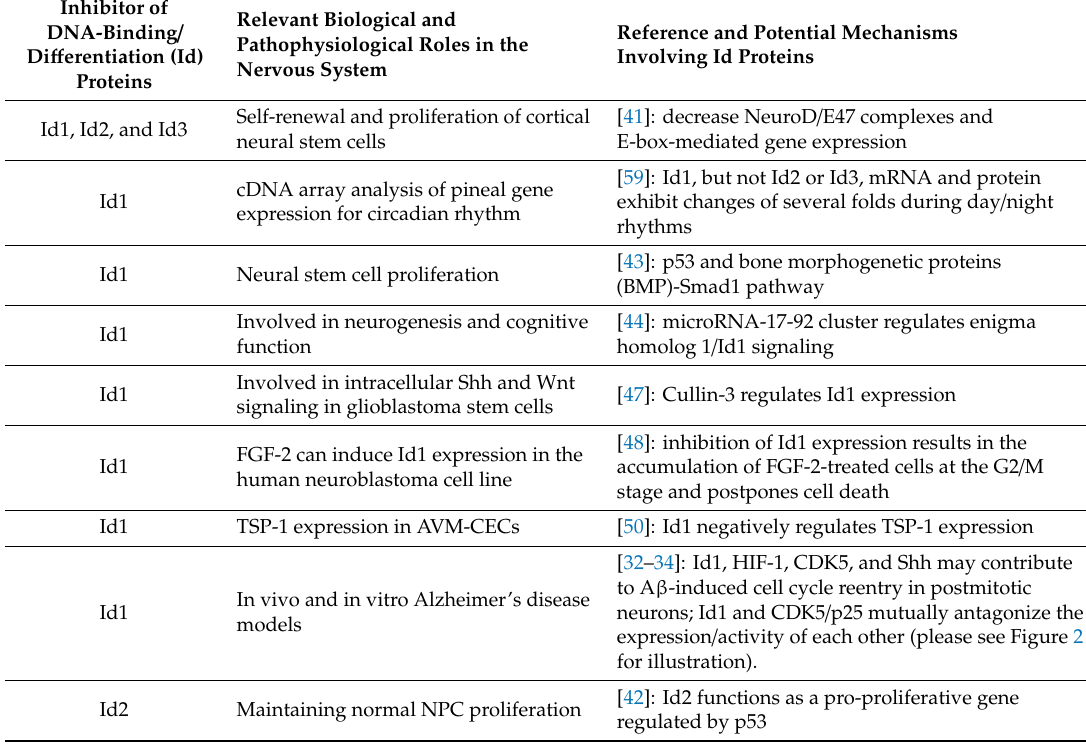
Table 1. Selected references of Id proteins with various biological and pathophysiological functions in the nervous